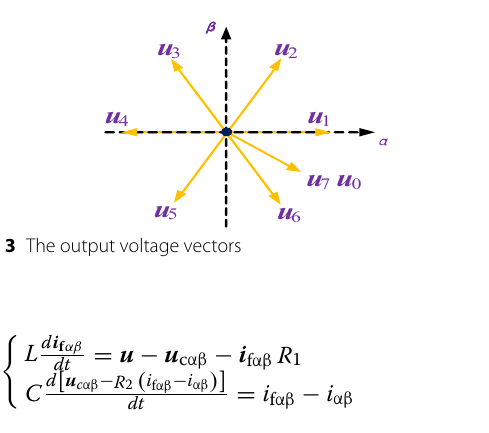
where L is the output filter inductance of the inverter, and C is the filter capacitor. R 1 and R 2 are the parasitic resist- ances of the filter inductor and filter capacitor, respec- tively. i fαβ and i αβ are the current vectors flowing through the filter inductor L and the grid-side inductor L g in the αβ coordinate, respectively. u is the output voltage vector of the inverter, and u c αβ is the voltage vector at the filter bus. Equation (7) can be discretized as: